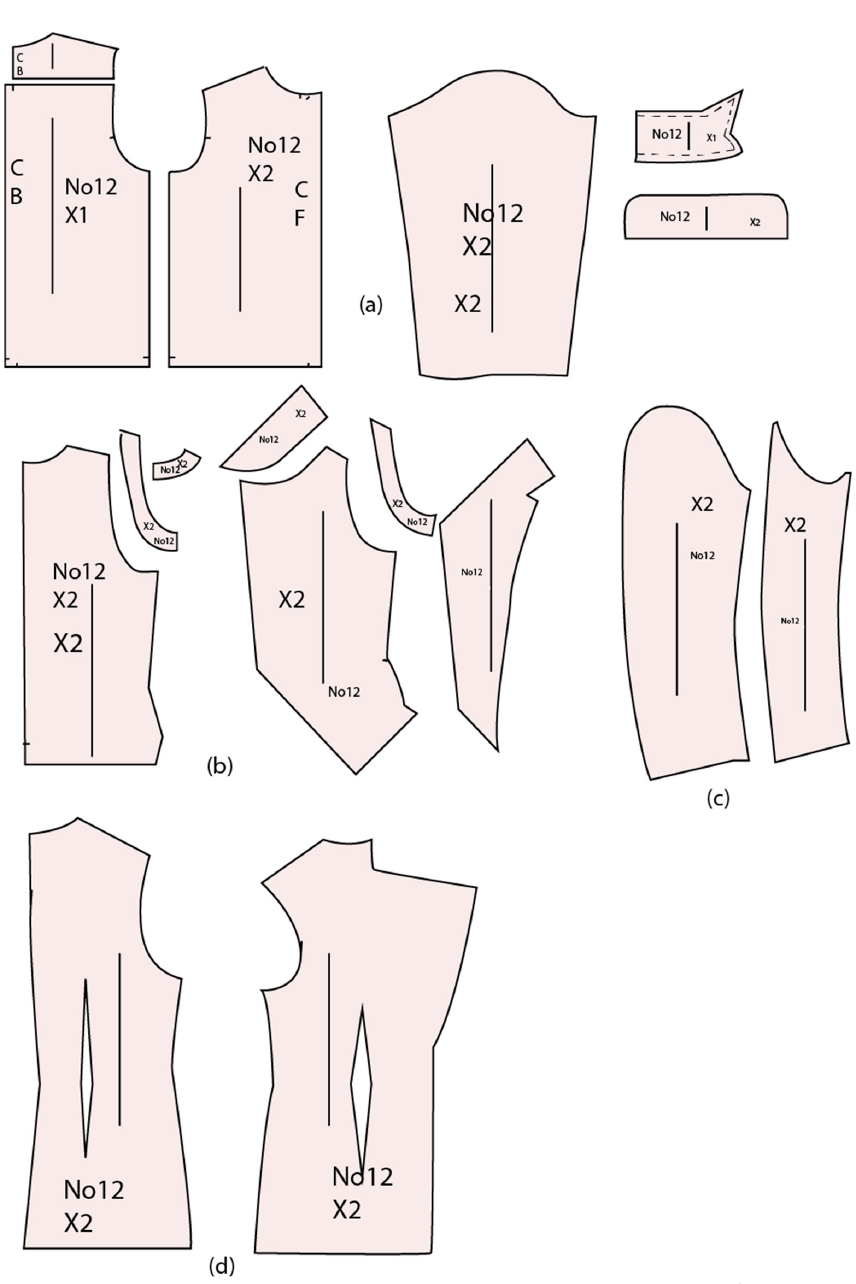
Figure 2. Polypattern CAD: basic shirt ( a ), vest ( b ), two-piece sleeve ( c ), basic jacket block ( d